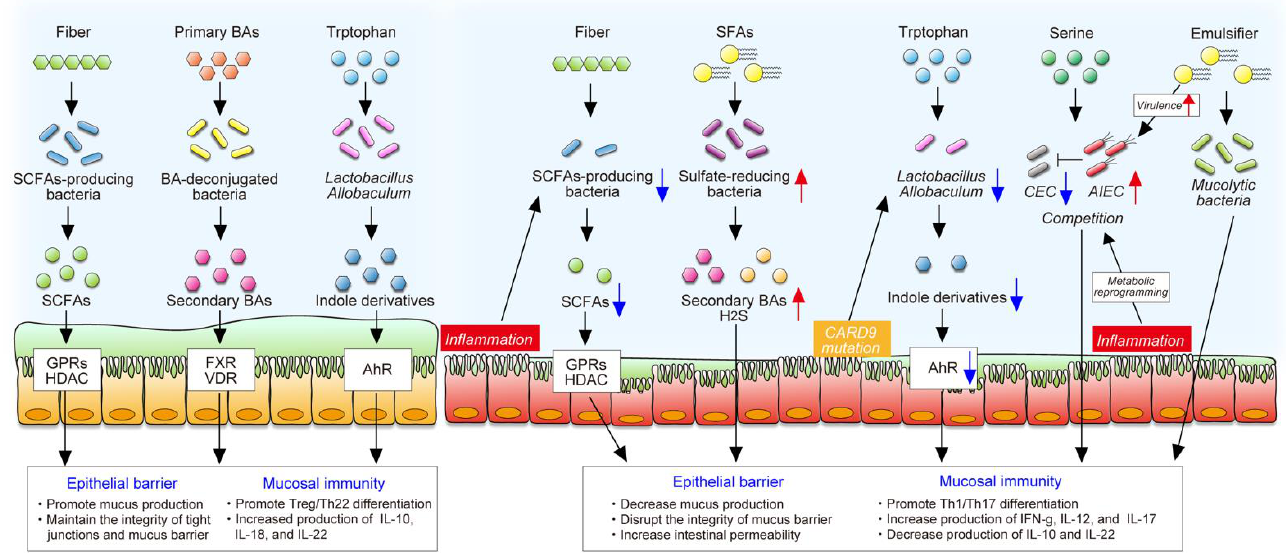
Figure 3. The roles of diet–microbe interaction in intestinal homeostasis and inflammation. The gut microbiota produces various metabolites from dietary components that exert important and diverse effects on intestinal homeostasis, including the maintenance of the epithelial barrier and mucosal immunity. In contrast, gut inflammation or mutation of certain genes change microbial composition and function, decreasing the production of beneficial microbial metabolites, such as SCFAs and indole derivatives. In addition, inflammation-induced metabolic reprogramming of adherent and invasive Escherichia coli (AIEC) enables it to adapt to the inflamed gut and to compete with commensal E. coli (CEC). Westernized diet, characterized by high saturated fat and emulsifiers, promotes blooms of certain pathobionts, some of which impair the epithelial barrier and stimulate a proinflammatory response.